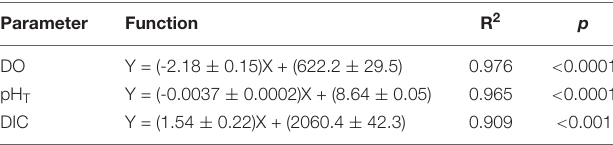
TABLE 4 | Results of linear regression of the mean values of DO, pH T , and DIC in bottom water against day of the year (YD) based on the composite data of 2017 and 2018.